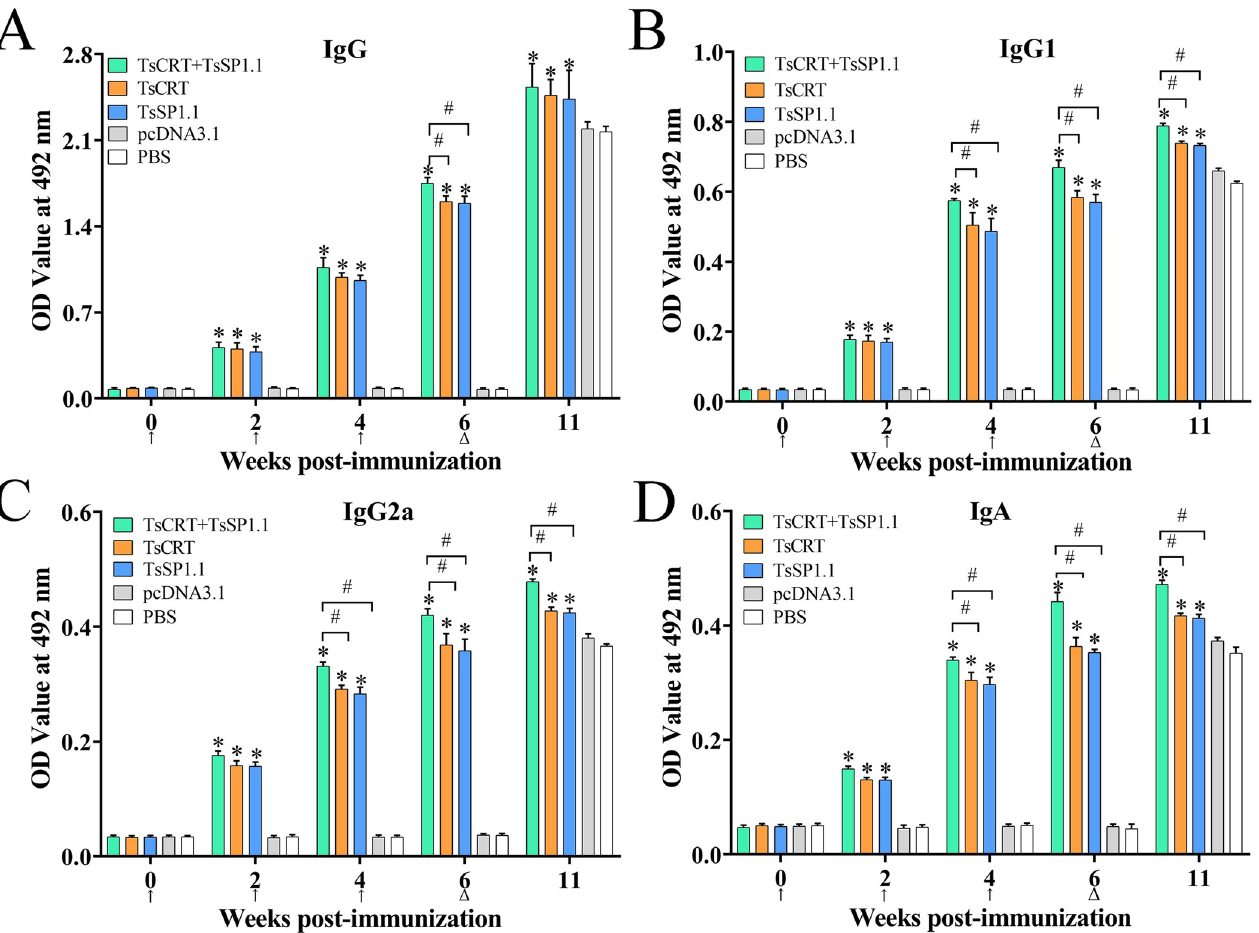
Fig 7. Serum anti- Trichinella antibody responses in mice vaccinated with TsCRT+TsSP1.1, TsCRT and TsSP1. 1 . Specific total anti- Trichinella IgG response was assessed in mice vaccinated with TsCRT+TsSP1.1, TsCRT or TsSP1.1 at various times following vaccination ( A ). Specific IgG1 ( B ) and IgG2a ( C ) subclass responses were also ascertained at various times after vaccination. D: IgA levels in vaccinated mice. The OD values from each group are presented as mean ± SD of antibody levels (n = 10). The vaccination times are shown with arrows ( " ) and the challenge time is indicated by triangles ( 4 ). � P < 0.05 compared to the PBS group. # P < 0.05 compared among various immunization